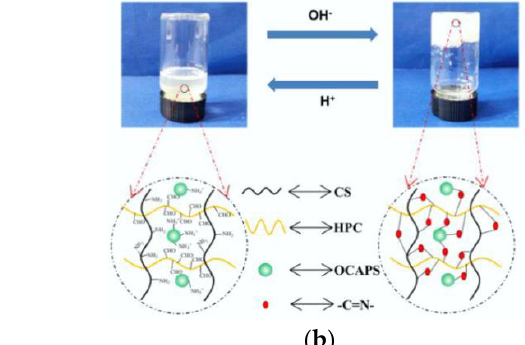
Figure 32. Self-healing performance ( A ) and continuous step strain measurements ( B ) of CS/HPC/POSS 40 hydrogel; Mechanical properties and results of compression tests on the original and self-healed CS/HPC/POSS 50 hydrogel ( C , D ). Reprinted from Reactive & Funct. Polym . 2021, 158 , Zhang, X.; Meng, Y.; Shen, W.; Dou, J.; Liu, R.; Jin, Q.; Fang, S., pH-responsive injectable polysac- charide hydrogels with self-healing, enhanced mechanical properties based on POSS, 104773, [102] Copyright (2021), with permission from Elsevier. Due to electrostatic interactions and the formation of hydrogen bonds between OCAPs and amide linkers in poly(N-isopropylacrylamide) (PNIPAM) chains, silsesqui- oxane molecules could also act as effective physical crosslinkers in a nanocomposite hy- drogel (OCAPS- PNIPAM), which significantly reduced the loading of N,N′ -meth- ylenebisacrylamide (BIS) (50 – 100 ppm) used as a chemical crosslinking agent [103]. Wa- ter-soluble OCAPS molecules aggregated in solution into nanoparticles with 7 – 20 nm size